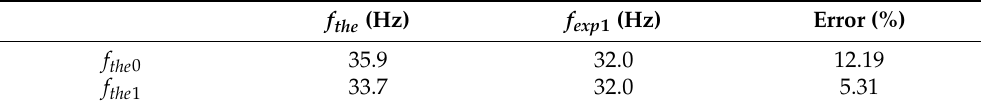
Figure 7. Frequency response of the feed system in the static state. Table 3. Theoretical and experimental results of system frequency under static state.